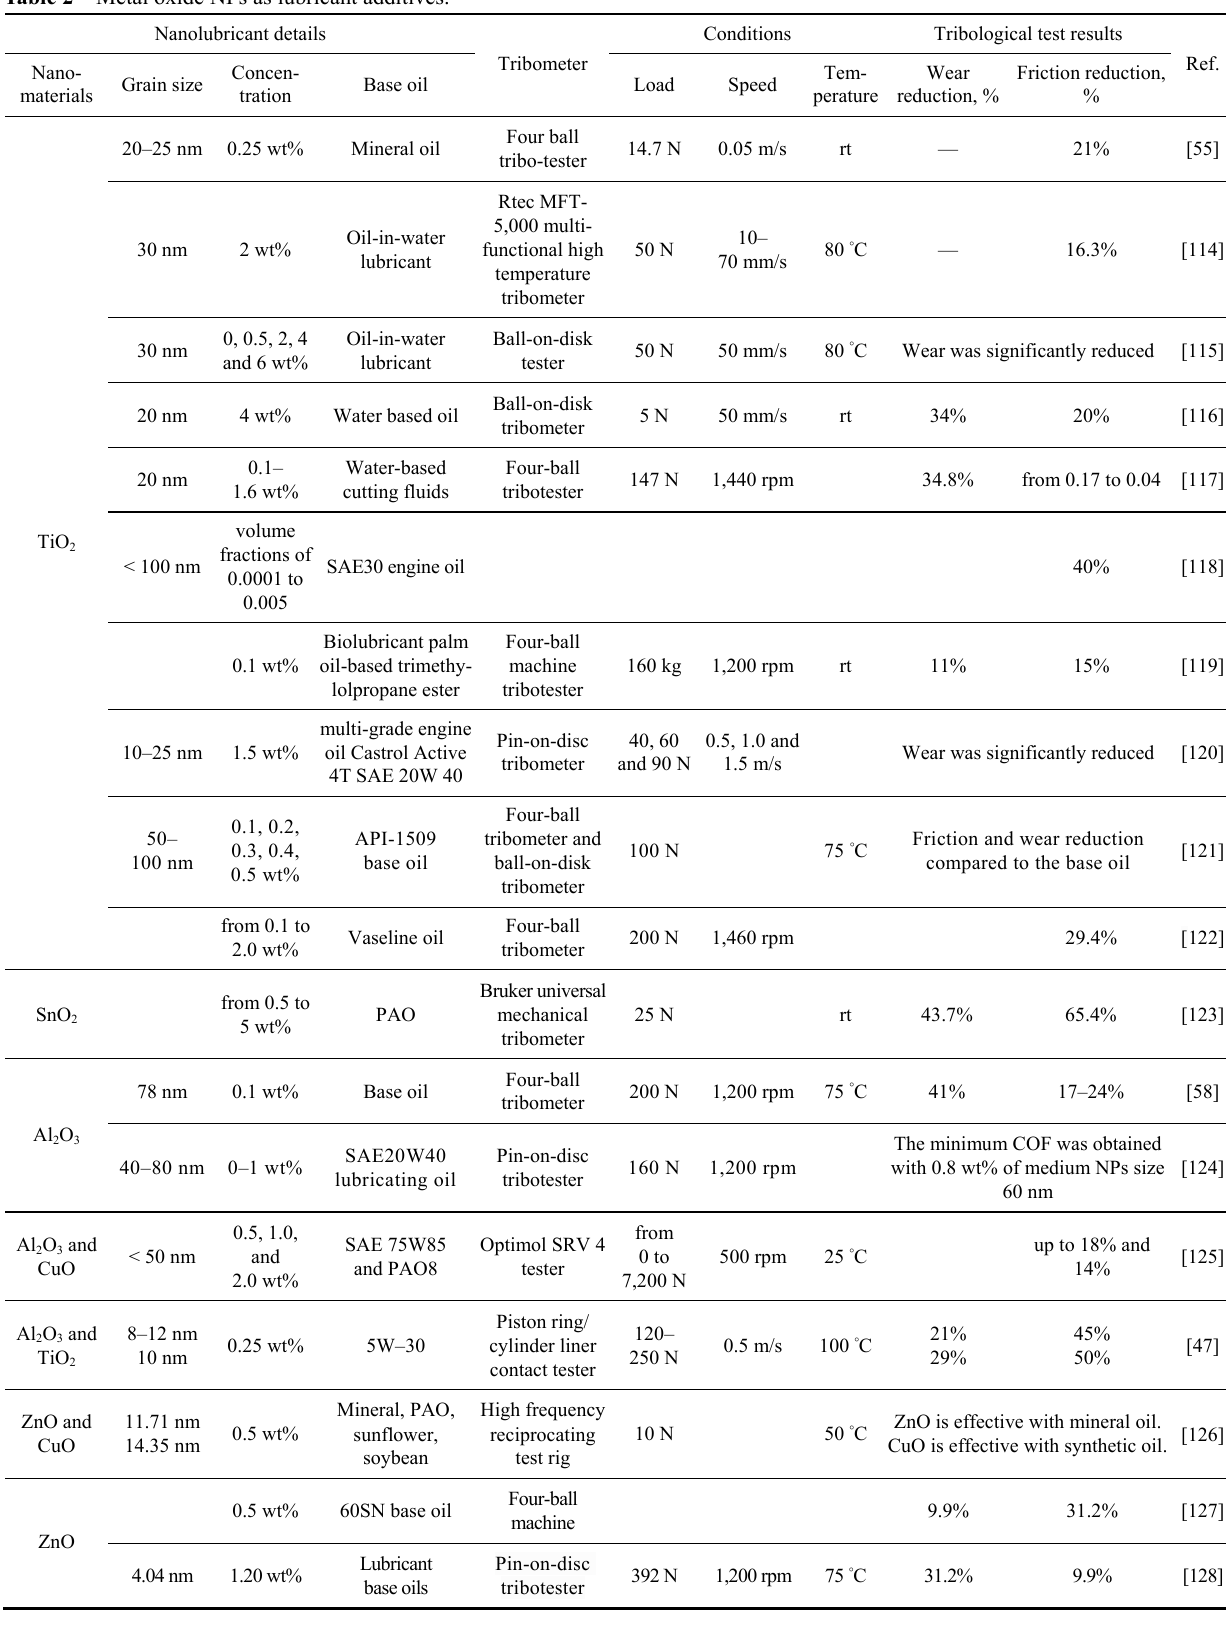
Table 2 Metal oxide NPs as lubricant